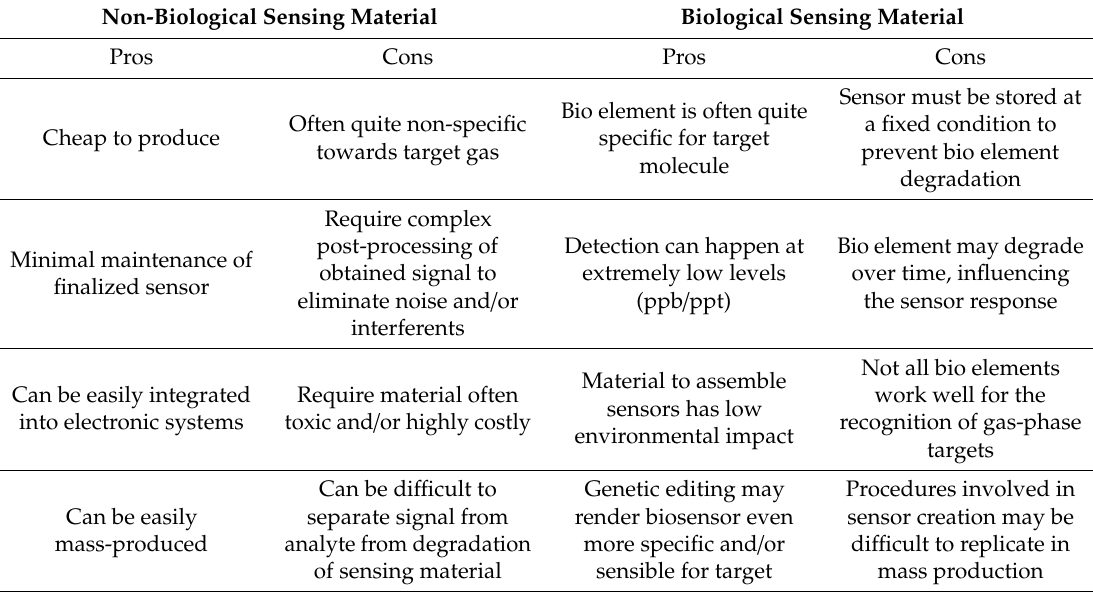
Table 6. Comparison between gas sensors based on non-biological and biological sensing